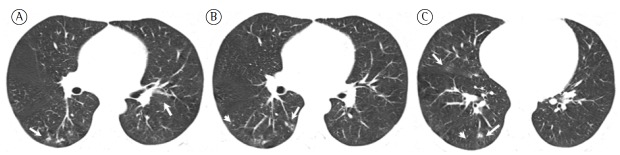
 TC de tórax na admissão hospitalar revelando micronódulos
parenquimatosos indistintos (setas curtas) com espessamento dos septos
interlobulares e áreas de atenuação em vidro fosco difusas e sutis (setas
longas).